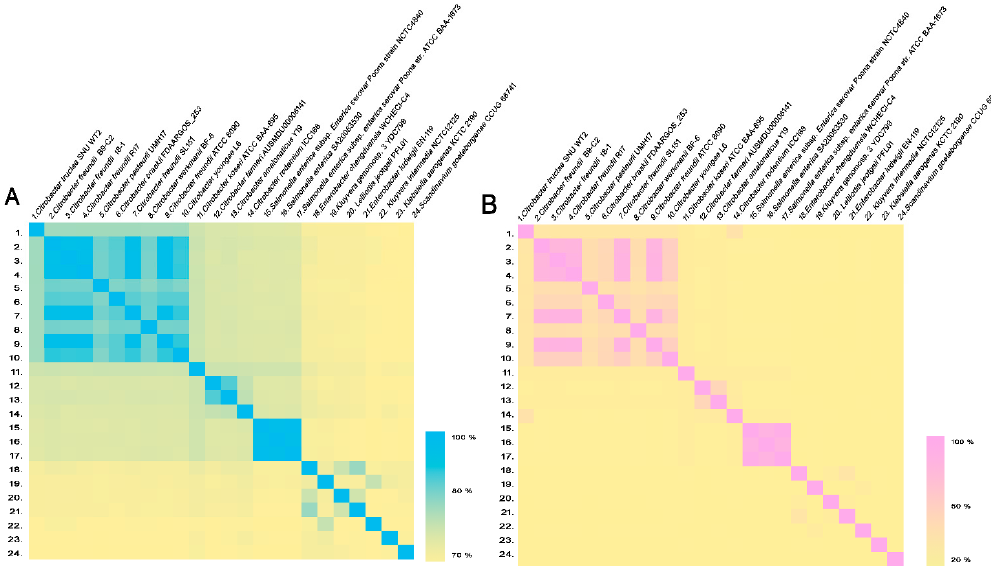
Figure 1. Heat map of average nucleotide identity (ANI) values and genome-to-genome distance calculator (GGDC) values compared among 24 related strains. ( A ) ANI heat map. ( B ) GGDC heat map. ANI and GGDC values are indicated by the color intensity. The strain numbers in Figure 1 are the same as that in Table 1.